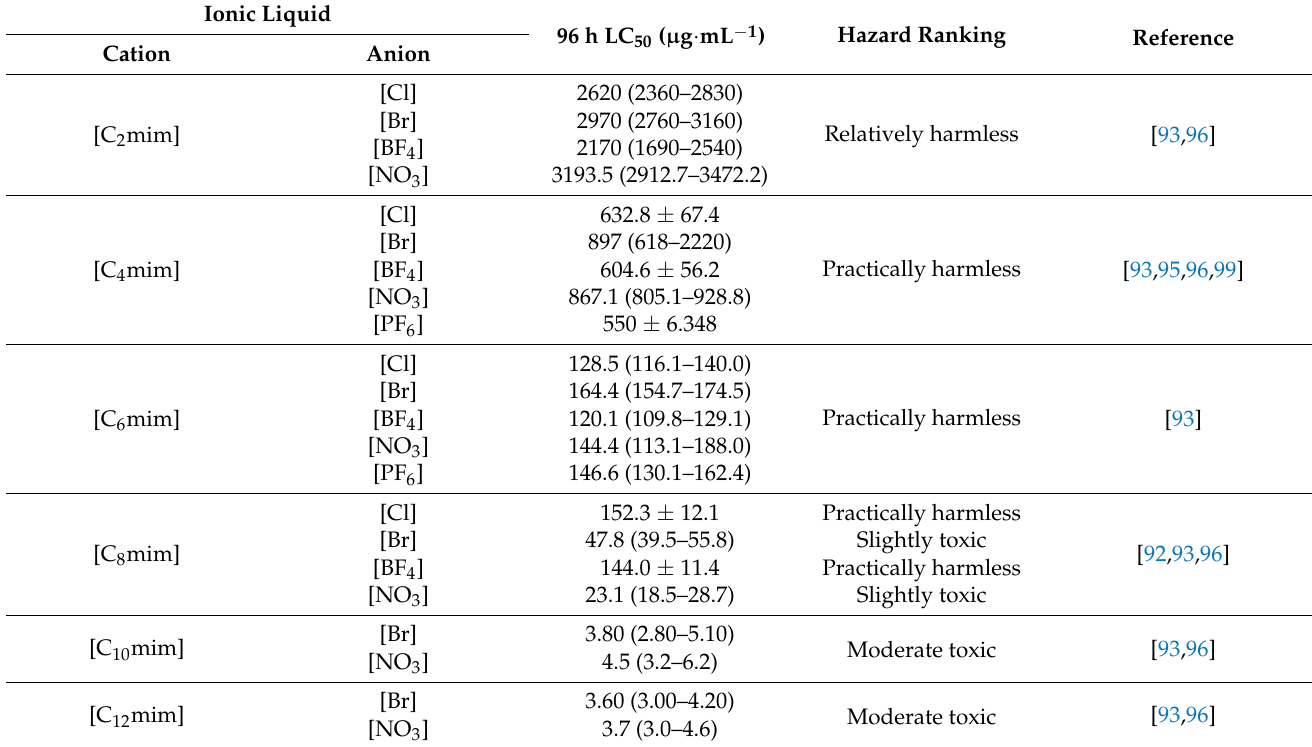
Table 4. The median lethal concentration (LC 50 ) values and hazard ranking for zebrafish ( Danio rerio ) at 96 h after acute exposure to imidazolium-based